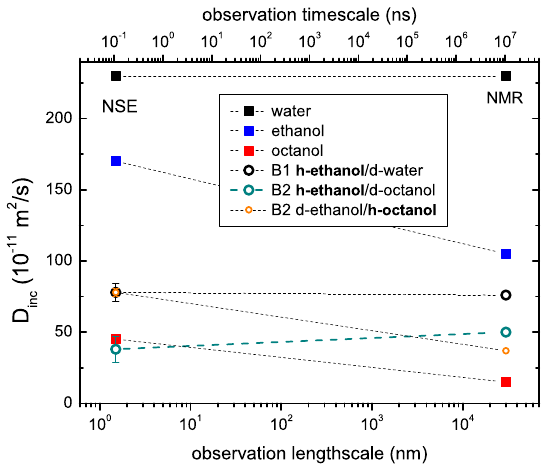
Figure 5. Self di ff usion coe ffi cients from NSE and NMR for the pure compounds and binary mixtures, measured at 298 K. In the binaries, the component characterized is in bold in the legend. Lines are only guides for the eye. Note the exceptional increase of the ethanol di ff usion coe ffi cient between NSE and NMR in the ethanol-octanol